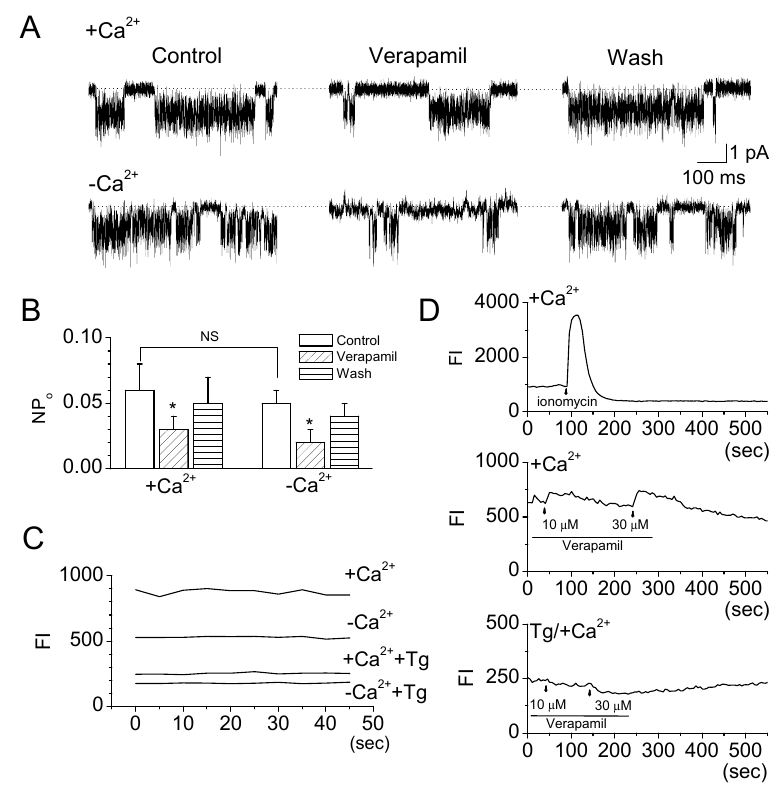
Figure 5. Effect of extracellular Ca 2 ⁺ on the inhibition of TRESK channel activity by verapamil. ( A ) Effect of extracellular Ca 2 ⁺ on verapamil effect. The channel activity was recorded in 5 mM KCl solution at 0 mV with and without extracellular Ca 2 ⁺ . The extracellular Ca 2 ⁺ -free solution contains 0 mM Ca 2 ⁺ and 5 mM EGTA; ( B ) Summary of the effects of verapamil on single-channel currents in the presence and absence of extracellular Ca 2 ⁺ . Data represent the mean ± SD of three repeated experiments. * p < 0.05 compared with the corresponding control; ( C ) Basal Ca 2 ⁺ levels of TG neurons in the presence and absence of extracellular Ca 2 ⁺ and in the depletion of Ca 2 ⁺ from endoplasmic reticulum with thapsigargin (Tg). Tg (10 μ M) was applied to TG neurons for 10 min before the recording of the basal Ca 2 ⁺ level; and ( D ) Effect of verapamil on the basal Ca 2 ⁺ level in TG neurons in the presence of extracellular Ca 2 ⁺ and Tg. FI: fluorescence intensity (arbitrary units) of the cells. +: presence of extracellular Ca 2+ , –: absence of extracellular Ca 2+ .